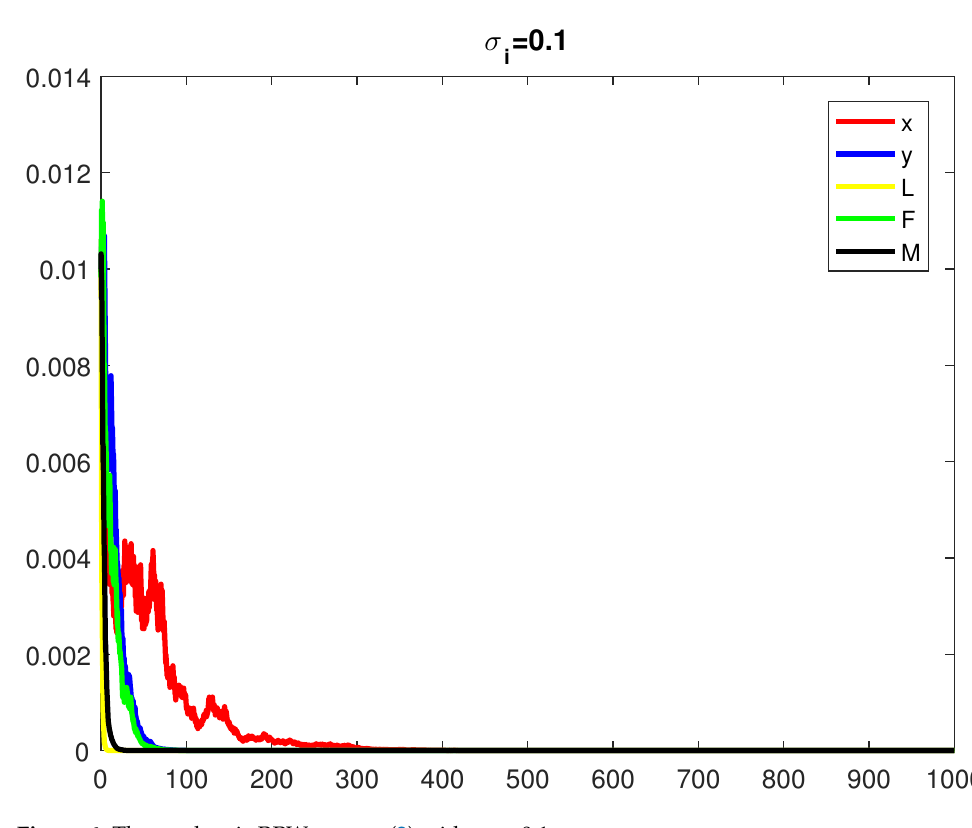
Figure 6. The stochastic RPW system (2) with σ i = 0.1.